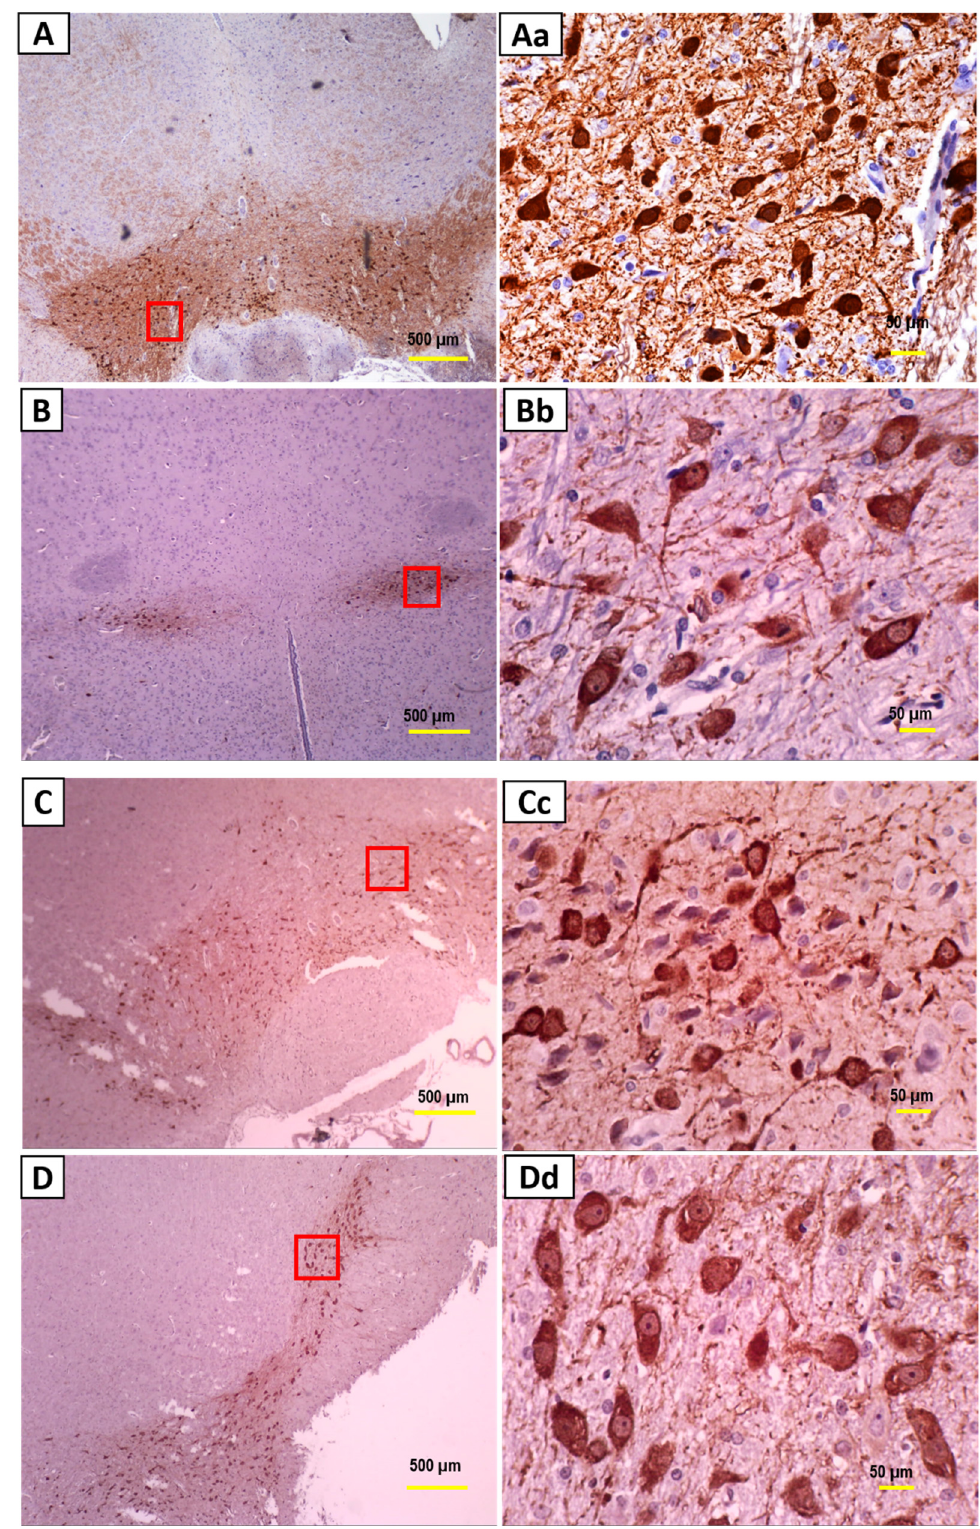
Figure 4. Photomicrographs of tyrosine hydroxylase (TH)-immunostained coronal sections of the substantia nigra (SN) from the ( A ) control group, ( B ) 250 µg 6-OHDA-injected group, ( C ) 250 µg 6-OHDA + α -T3-treated group, and ( D ) 250 µg 6-OHDA + γ -T3-treated group. (Left half ( A – D ) Lower magnification, Scale bar: 500 µm; Right half ( Aa – Dd ) higher magnification, Scale bar: 50 µm).